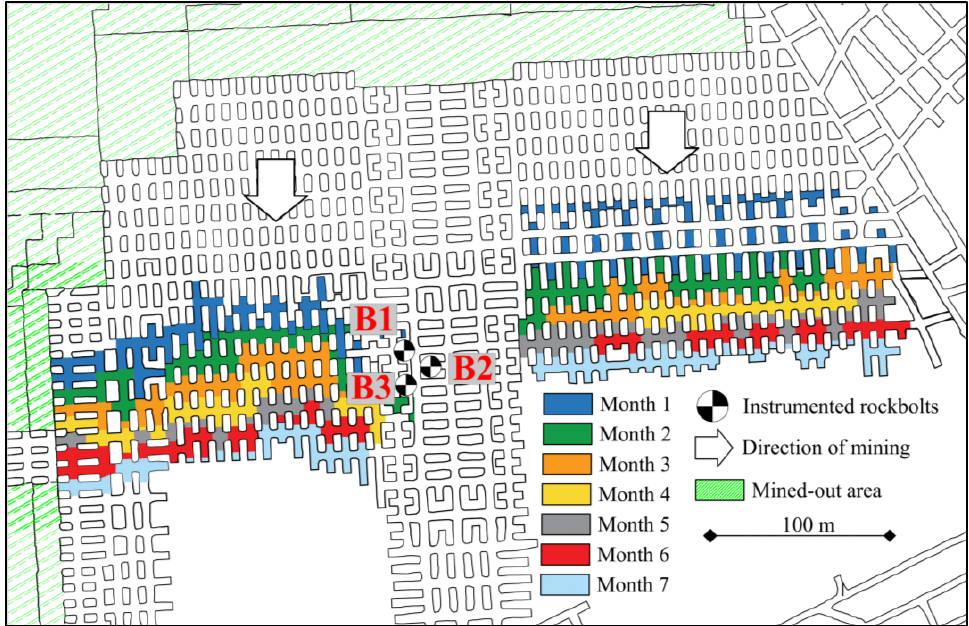
Figure 11. Map of the mining panel with stages of the operation ’s progress.